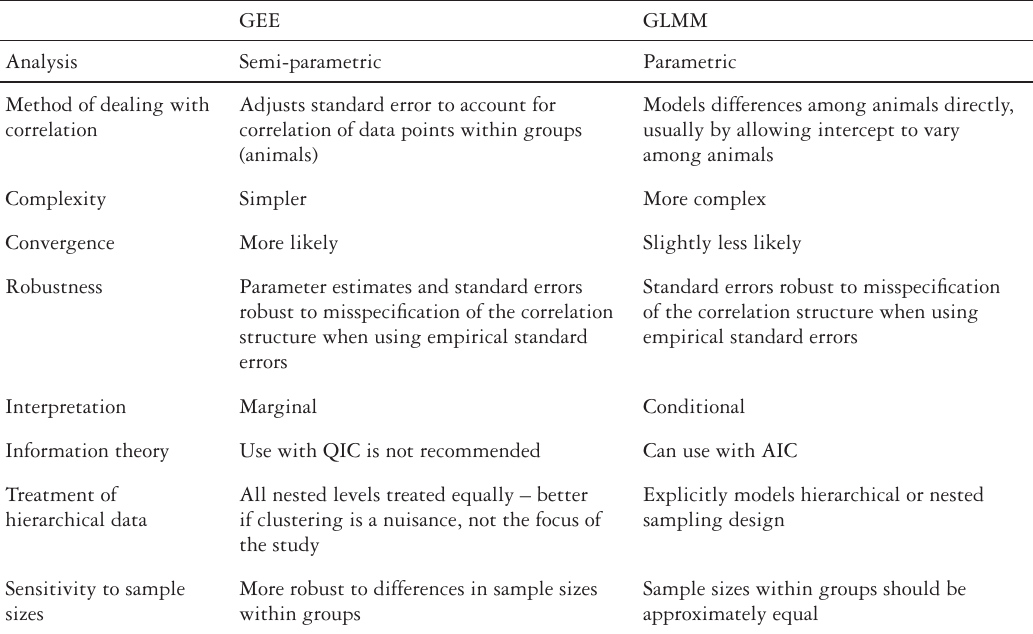
Table 1. Comparison between the use of generalized estimating equations (GEEs) and generalized linear mixed models (GLMMs) for developing resource selection functions using telemetry